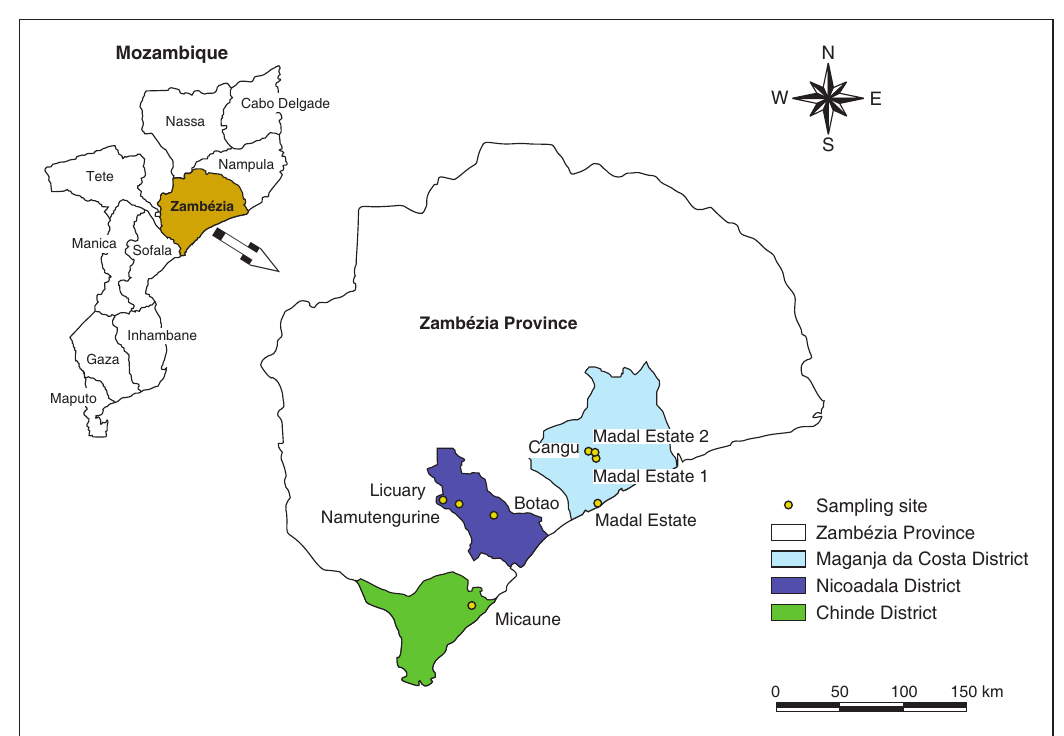
FIG. 1 Map of Zambézia Province indicating the location of the seven sampling sites in the three